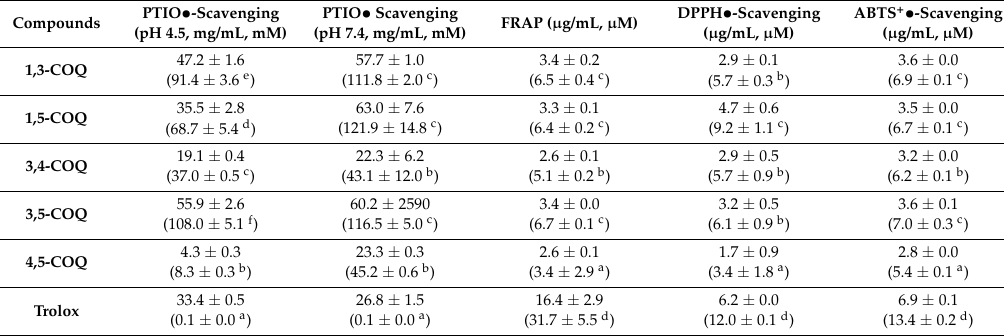
Table 1. The IC 50 values of five di-COQs in various antioxidant assays.